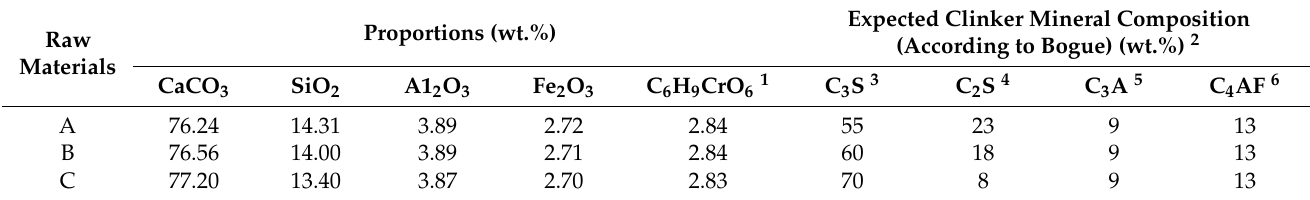
Table 1. Proportions and expected mineral composition of the raw materials.